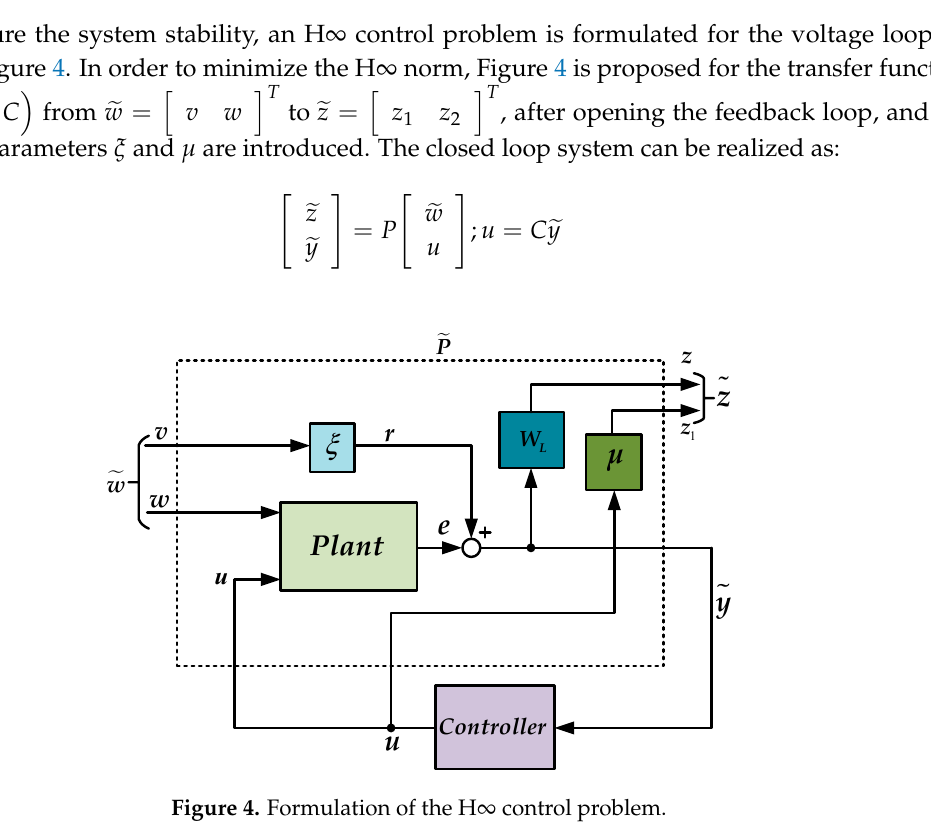
Figure 3. Sketch of a single-phase inverter.